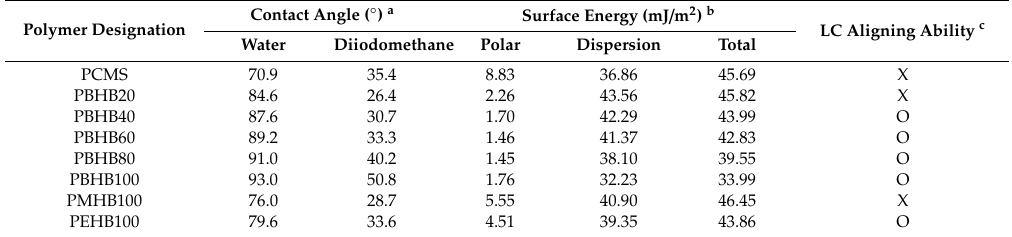
Table 2. Surface energy values and LC (liquid crystal) alignment properties of the polymers. Polymer